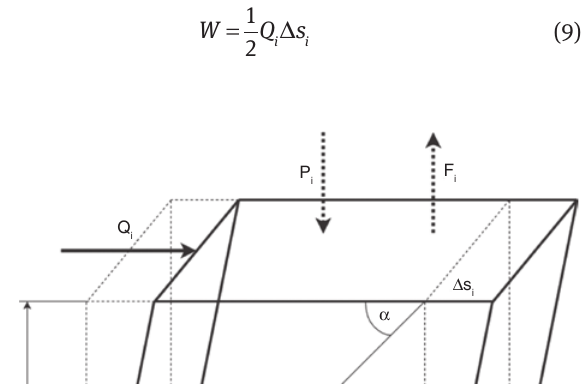
Each spring in the model is a cuboid of the surface material with its height being the height of the Winkler’s layer and its upper area is equal to S . When two sur- faces: “rough surface” and “flat and rigid surface” are moving laterally with respect to each other, each cuboid is sheared. A schematic of a sheared element is shown in Figure 3. The work of the shear force is: